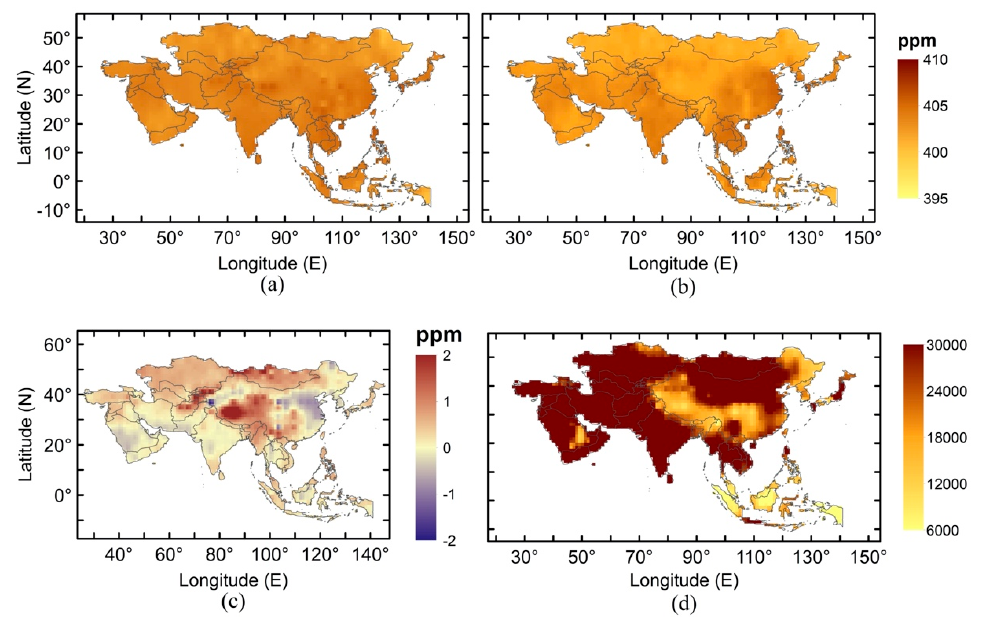
Figure 3. Distribution of 5 years mean XCO 2 over Asia ( a ) from CT; ( b ) Orbiting Carbon Observatory 2 (OCO-2); ( c ) their di ff erences (CT-OCO2); ( d ) and the total number of datasets from OCO-2 in each grid.